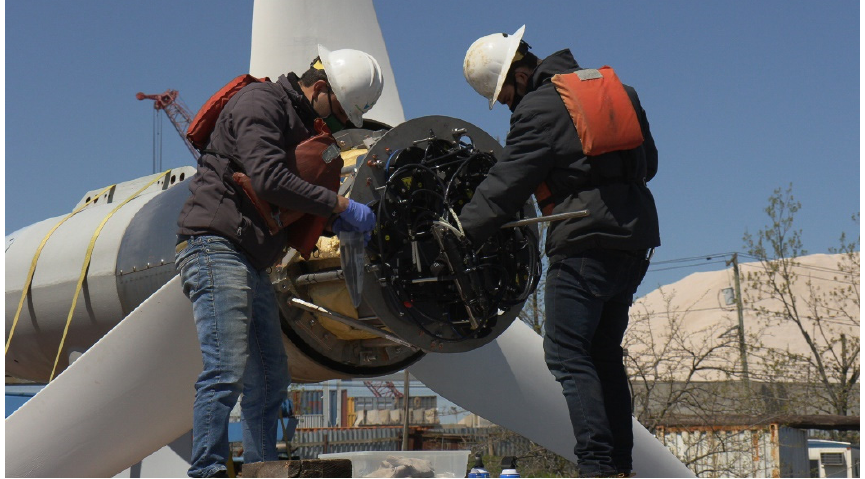
Figure 2. Verdant Power turbine with NREL thermoplastic blades and the NREL data acquisition system (NDAQ).